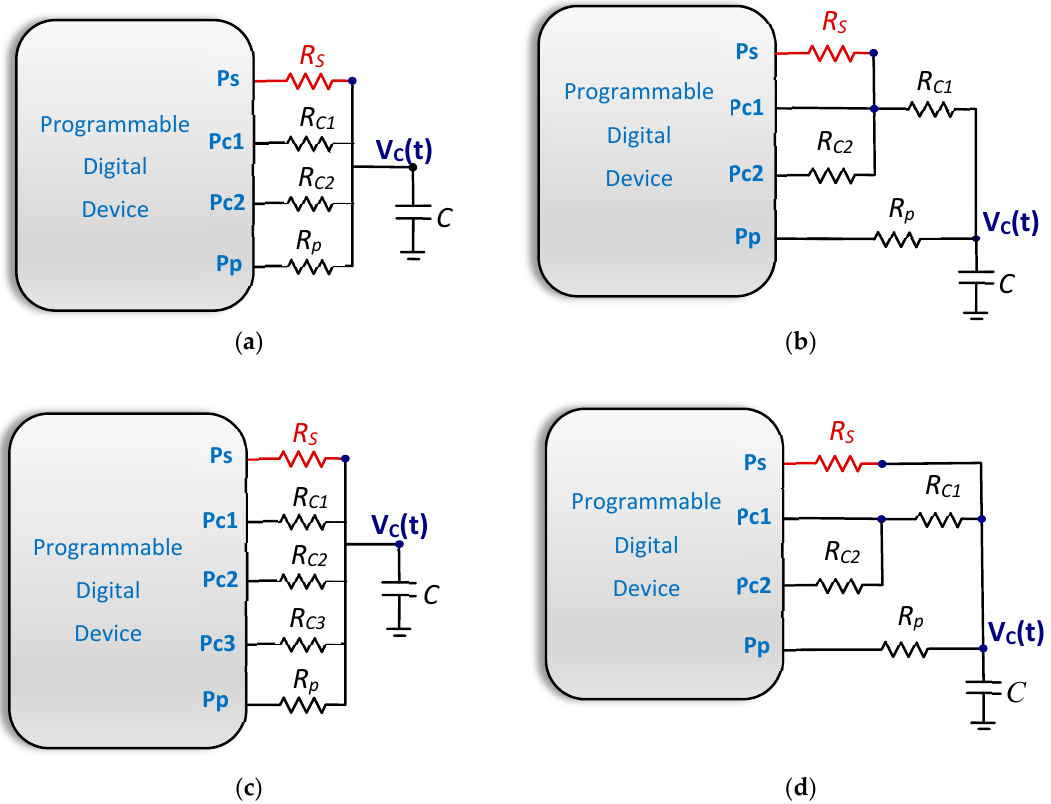
Figure 1. Different types of resistive Direct Interface Circuits (DICs) proposed in the literature (resistor/sensor to be estimated shown in red). ( a ) Two-Point Calibration Method, TPCM. ( b ) Three-Signal Method, TSM. ( c ) DIC for measuring low resistance values. ( d ) DIC designed to reduce quantization error.